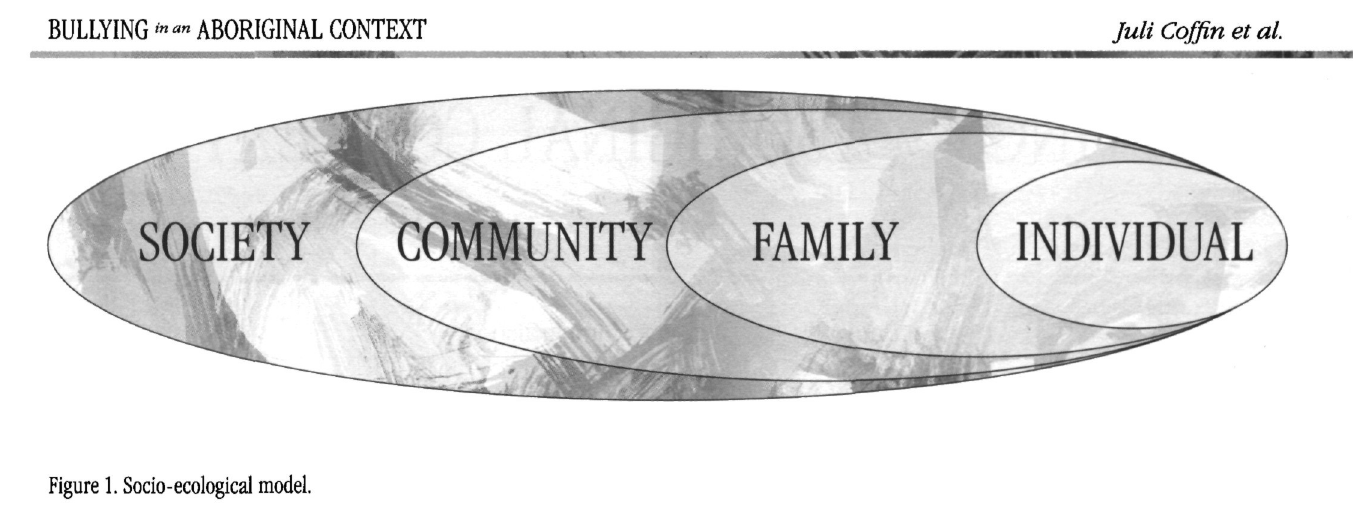
Figure 1. Socio-ecological